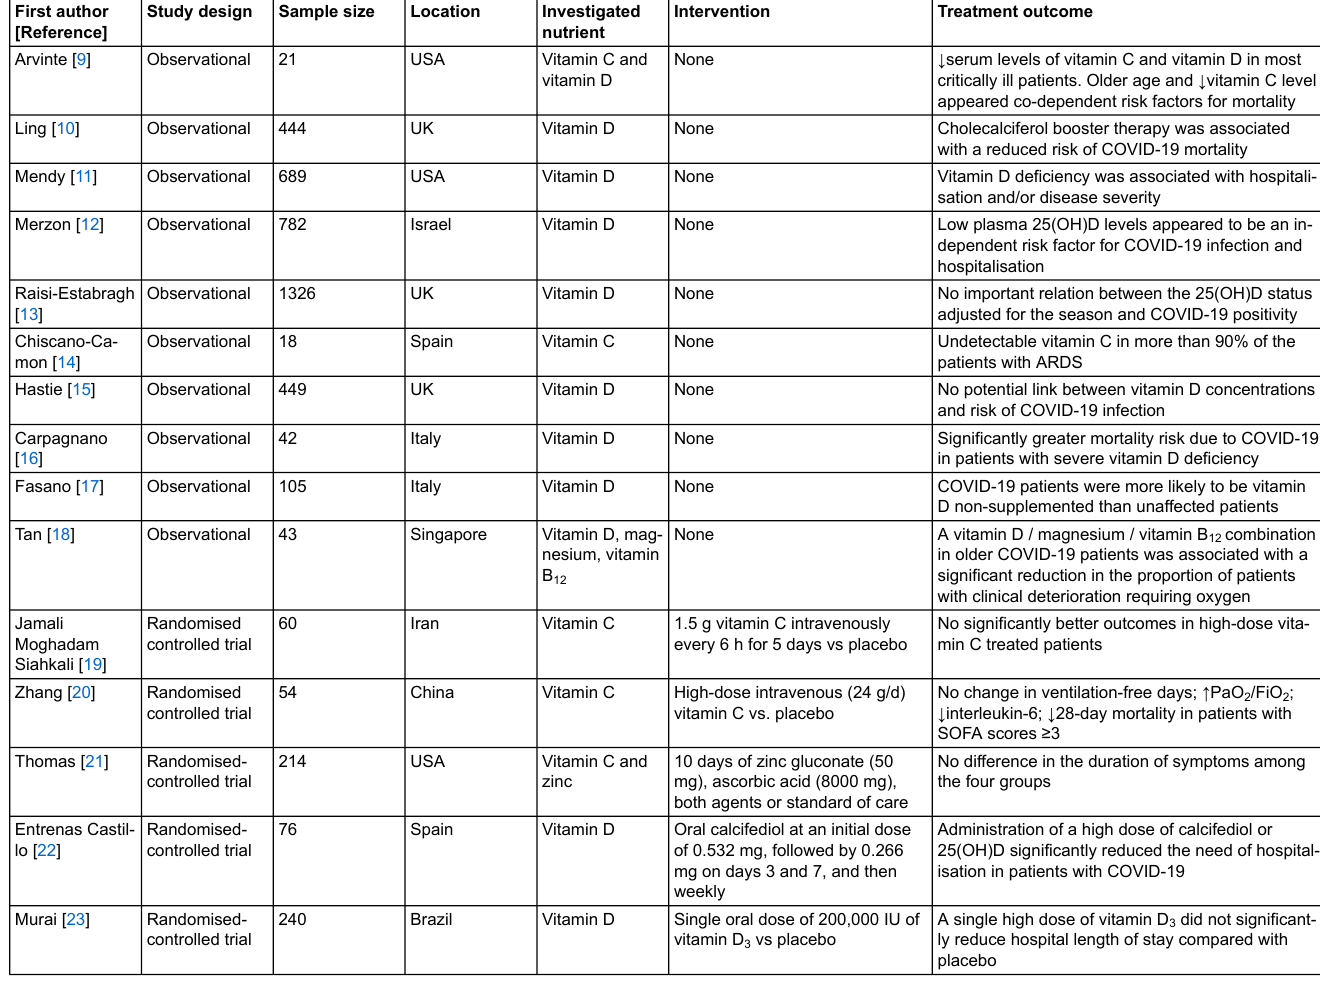
Table 1: Overview of recent trials investigating the role of vitamins and other micronutrients in patients with